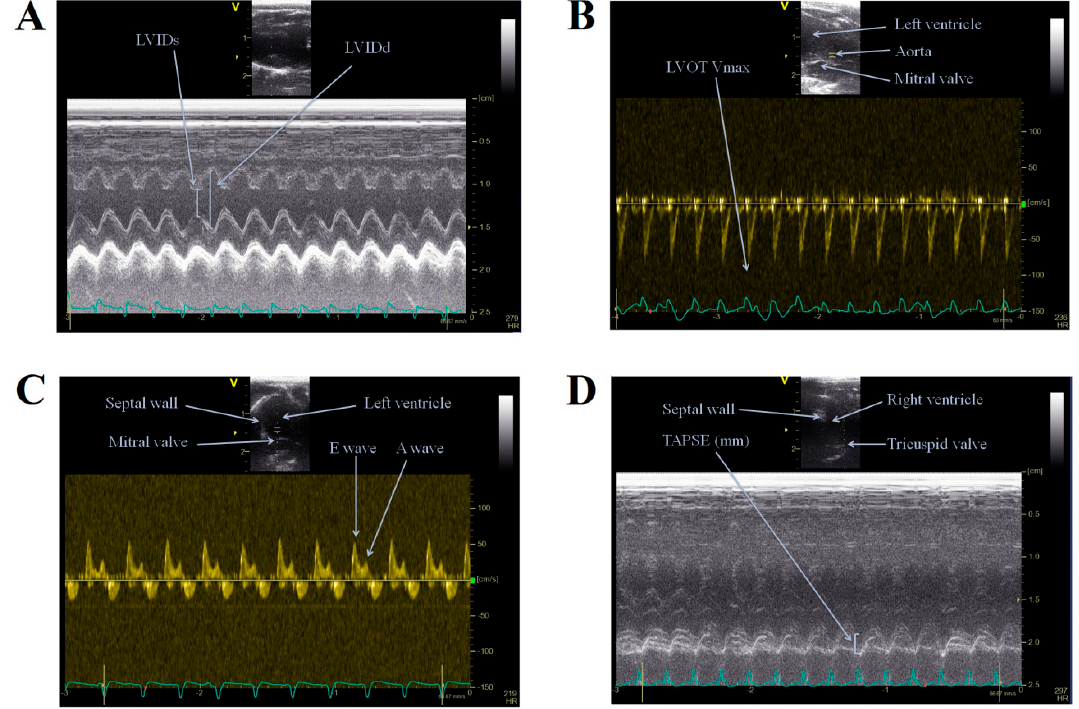
Figure 5. Representative images of echocardiographic examinations of rats in the study. ( A ) M-mode, left ventricle study; ( B ) PW (Doppler) mode, left ventricle outflow tract velocities; ( C ) PW (Doppler) mode, mitral inflow velocities; and ( D ) M-mode, right ventricle study. LVIDs: left ventricular internal diameter in systole; LVIDd: left ventricular internal diameter in diastole; LVOT Vmax: maximal velocity of left ventricle outflow tract; E wave: peak mitral early filling velocity; A wave: peak mitral late (atrial) filling velocity; TAPSE: tricuspid annular plane systolic excursion.